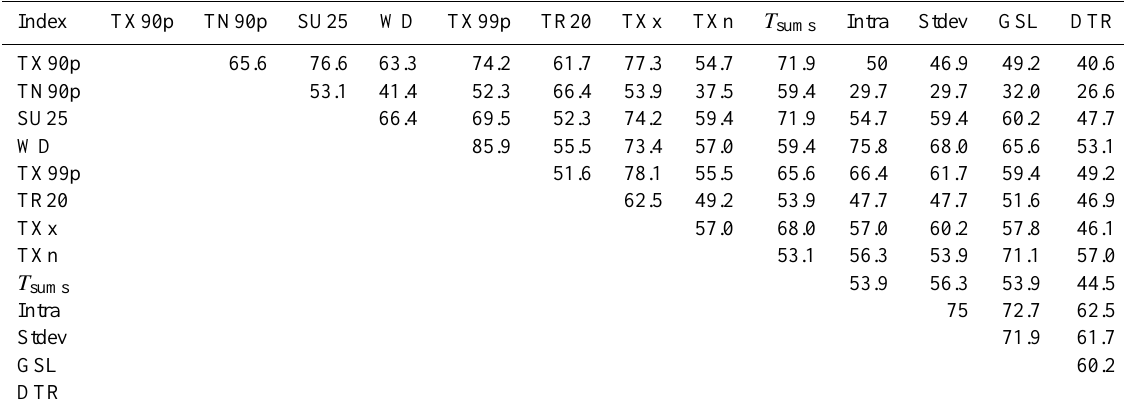
Table 3. The association between pairs of hot and variability extreme indices with respect to the sign of the trends at the 95% level (statistically positive, statistically negative, and statistically insignificant). Numbers indicate sign coincidences for each pair of indices.